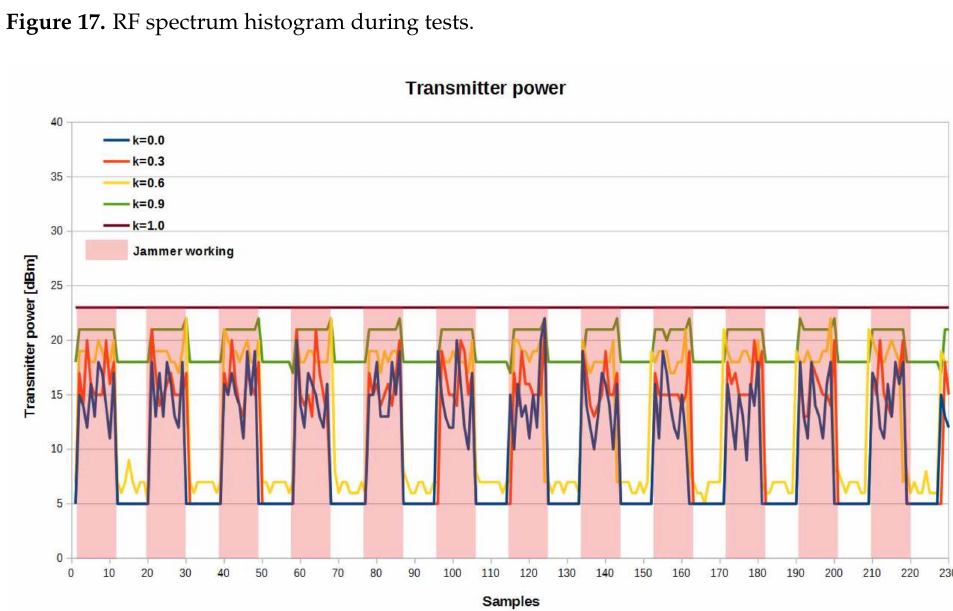
Figure 18. Transmitter power with and without jamming for different k